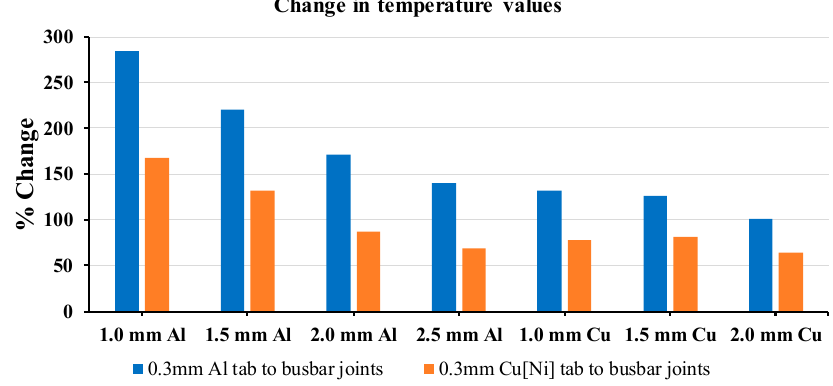
Figure 7. The percentage (%) changes in temperature due to application of 250 amp current for 60 s through di ff erent tab-to-busbar assemblies.